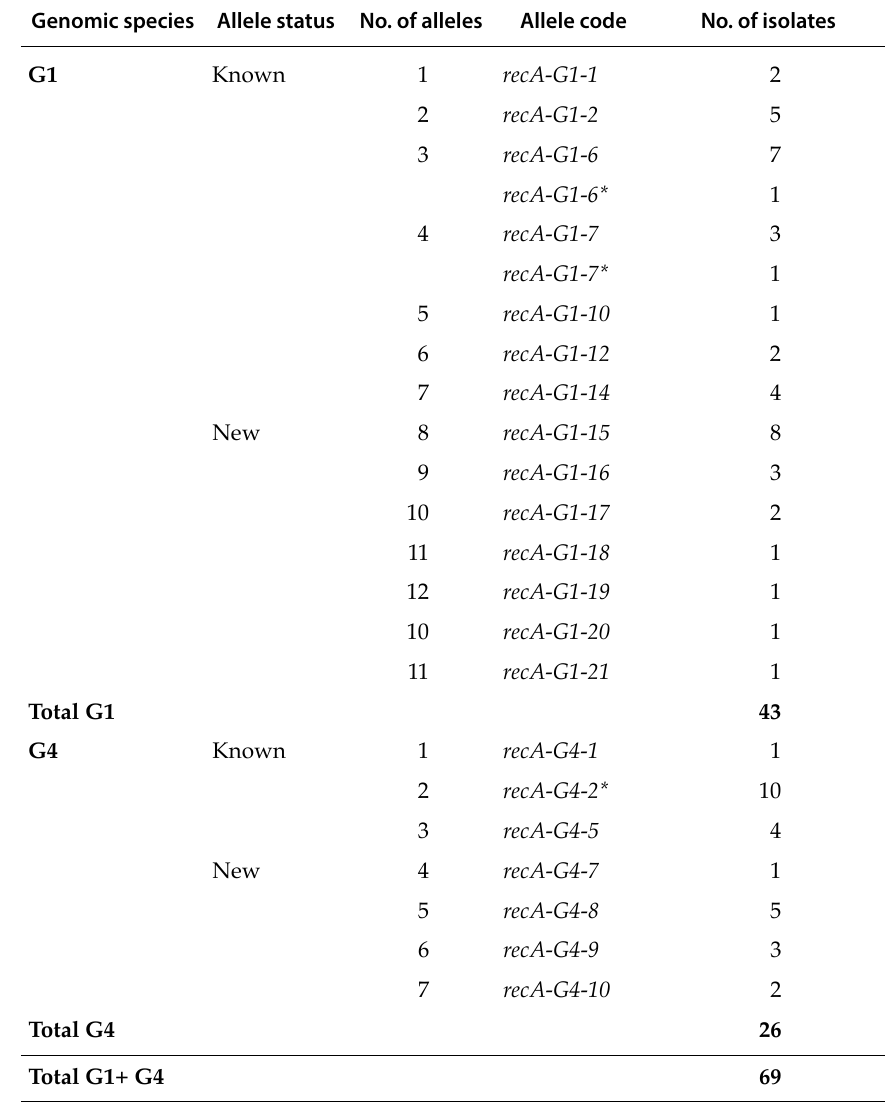
Table 2. The diversity and frequency of rec A alleles of the Agrobacterium tumefaciens biovar 1 soil populations from agricul- tural habitats in Slovenia.